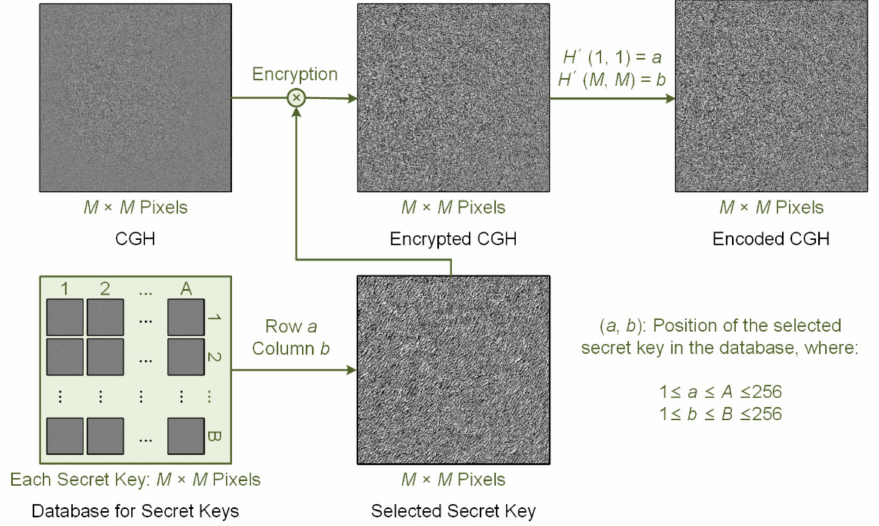
Figure 4. The encryption of the phase-only CGH before the